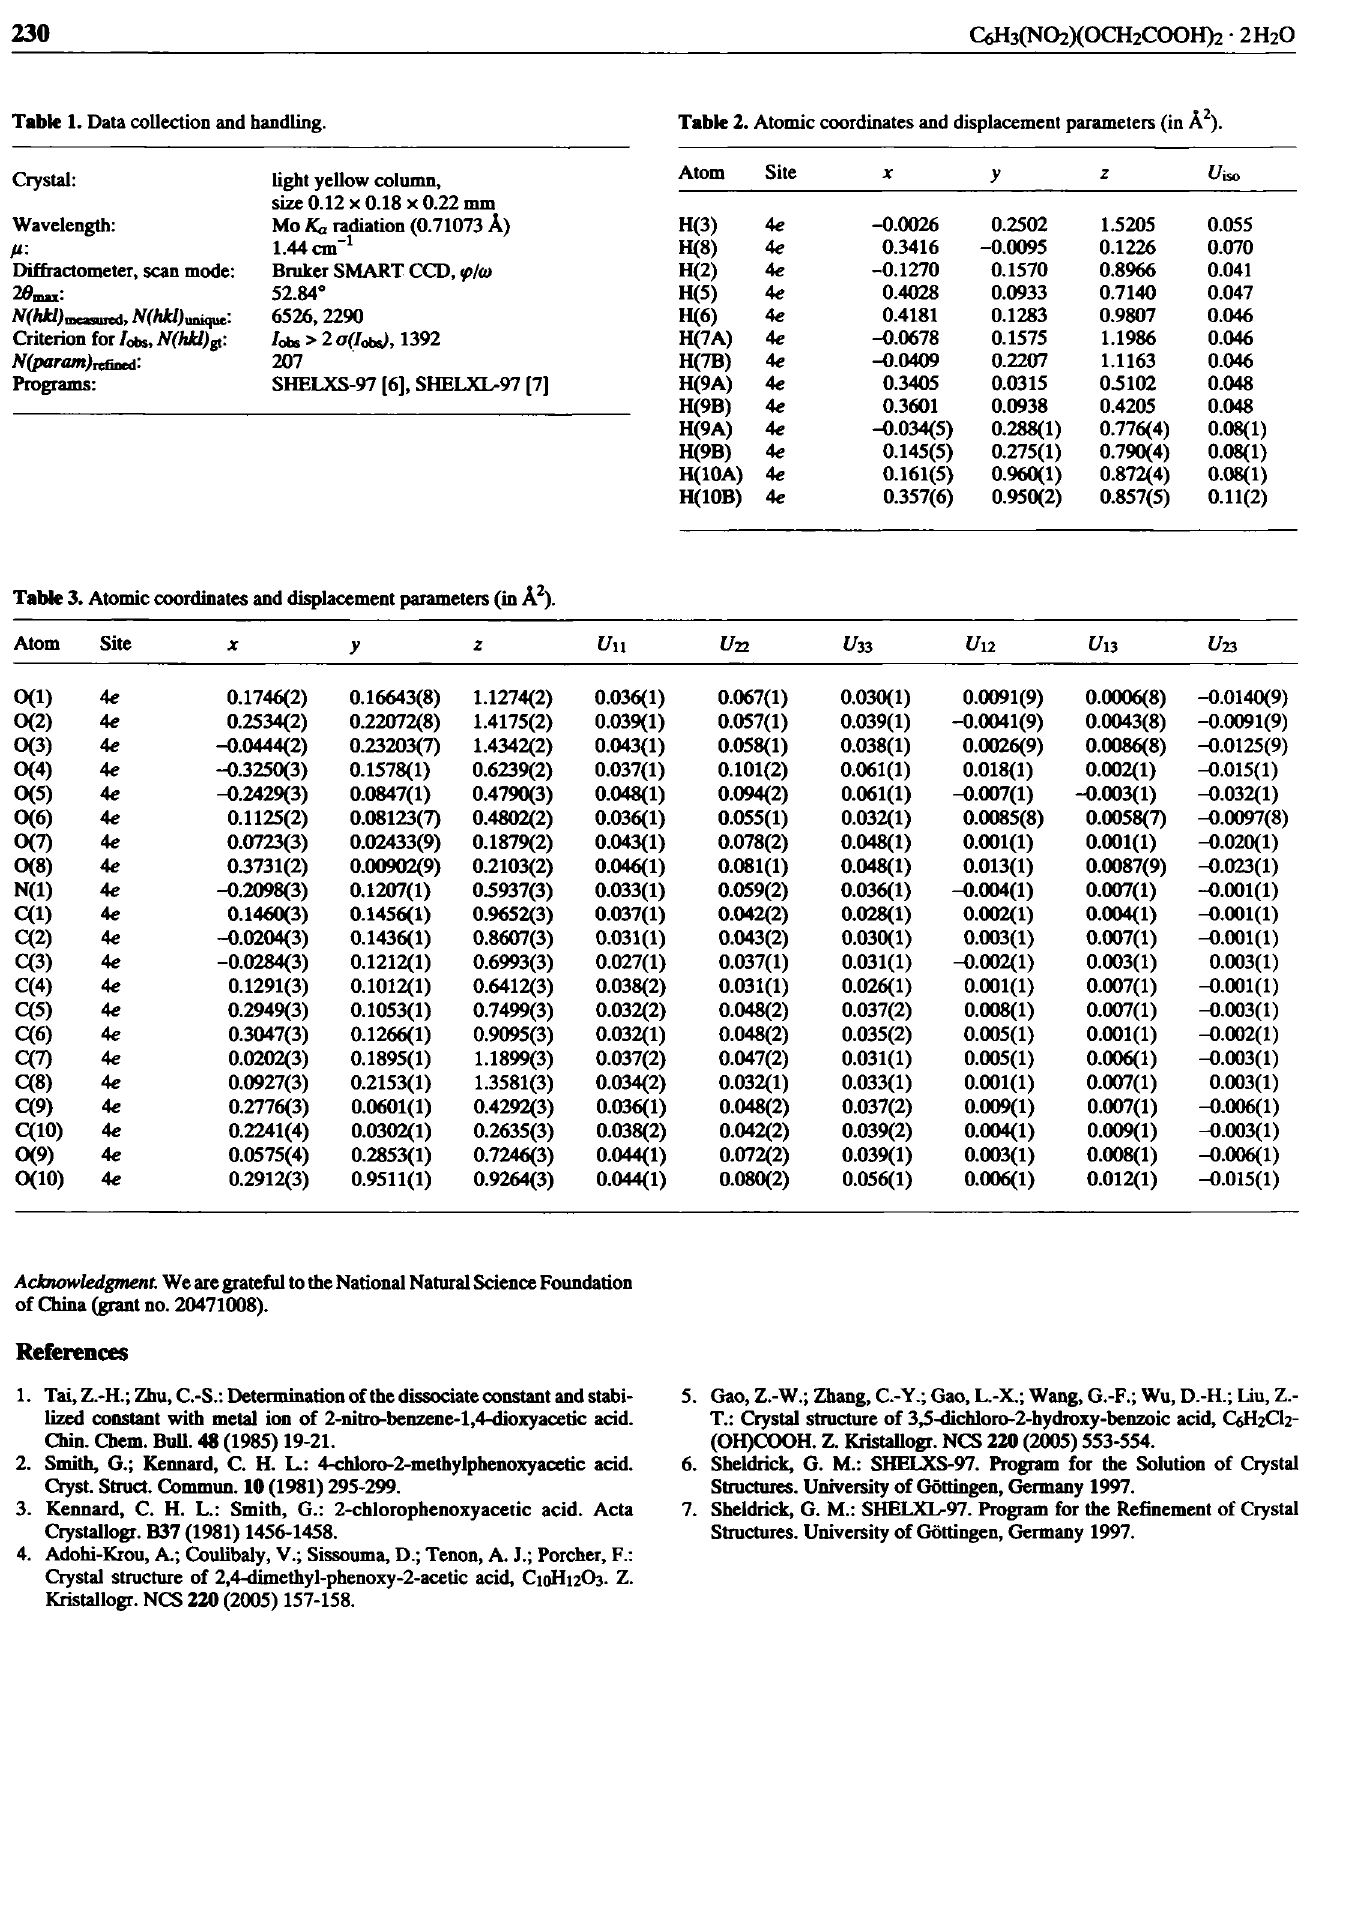
Table 1. Data collection and handling. Table 2. Atomic coordinates and displacement parameters (in Ä 2 ).